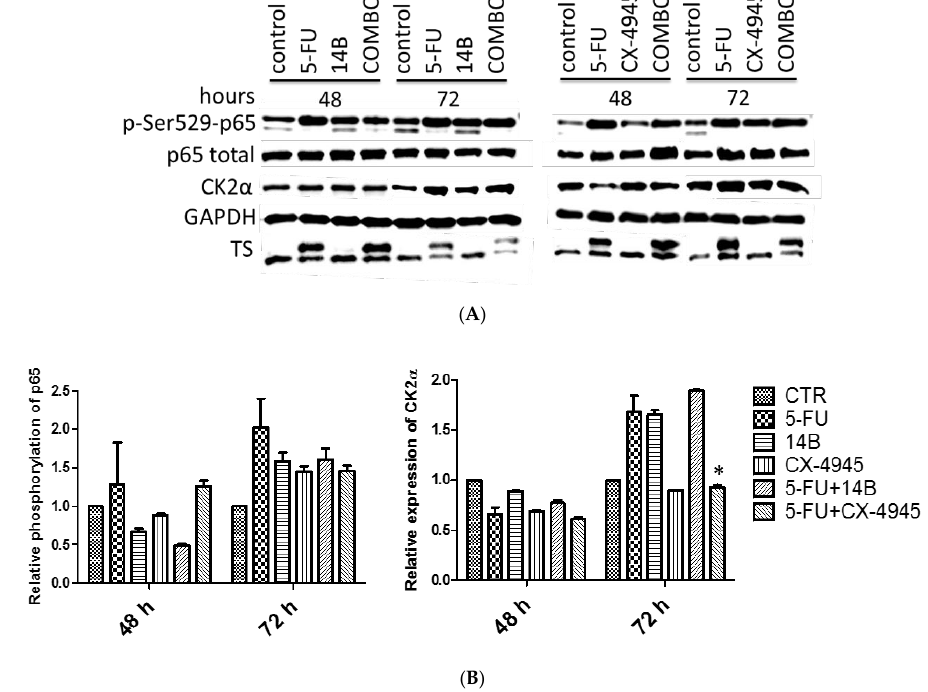
Figure 2. Western blot analysis of thymidylate synthase (TS), protein kinase CK2α subunit, and total nuclear factor kappa-light-chain-enhancer of activated B-cells p-65 subunit (NF-ĸB-p65 and p-Ser529-p65) in the crude extracts obtained from MDA-MB-231 cells after 48 h and 72 h of treatment with 15 µM 5-FU and 2 µM 14B, used separately and in combination (left panels), as well as 15 µM 5-FU and 5 µM CX-4945 used separately and in combination (right panels). GAPDH (glyceraldehyde 3-phosphate dehydrogenase) was used as a loading control for each sample. Preparation of cell extracts and protein detection are described in the Materials and Methods: ( A ) The representative blots; ( B ) densitometry quantifications for p-p65 and CK2α are shown in the graphs, with untreated cells serving as the reference point (1). * Statistically, significantly different from that of 5-FU-treated cells and the drug combinations by student’s t -test ( p ≤ 0.05) (see Materials and Methods). The complex of TS with 5-fluoro-dUMP (the upper line in TS, Figure 2A), indicating TS inhibition in MDA-MB-231 cells, was detected after 5-FU treatment, as well as after treatment with a combination of 5-FU with either 14B or CX-4945. Since the obtained results were inefficient to conclude about the molecular mechanism of the observed synergistic interactions, additional signaling pathways were studied.